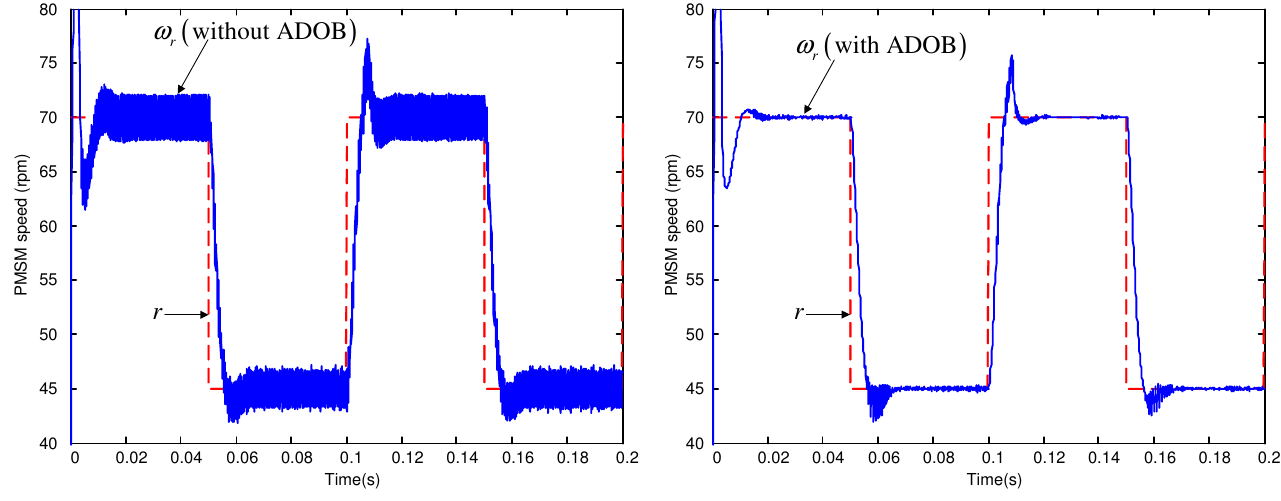
Figure 5. ( Left ) Permanent magnet synchronous motor (PMSM) speed response without ADOB; ( Right ) PMSM speed response with